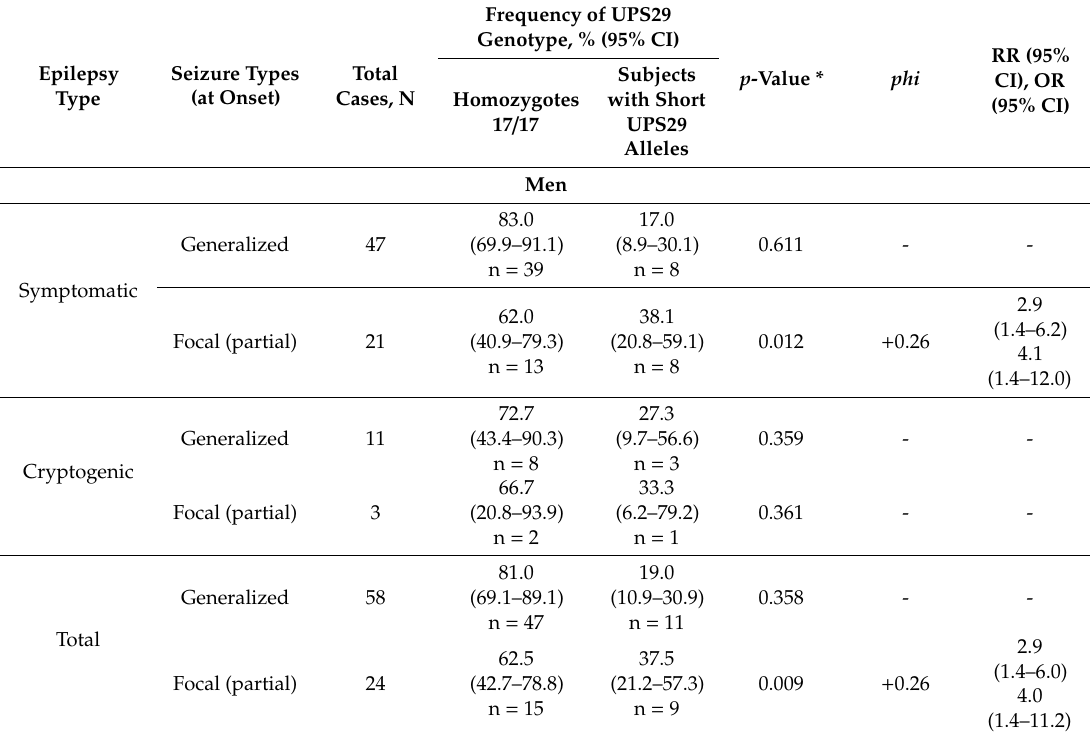
Table 4. Association of UPS29 genotype with the type of seizure at the